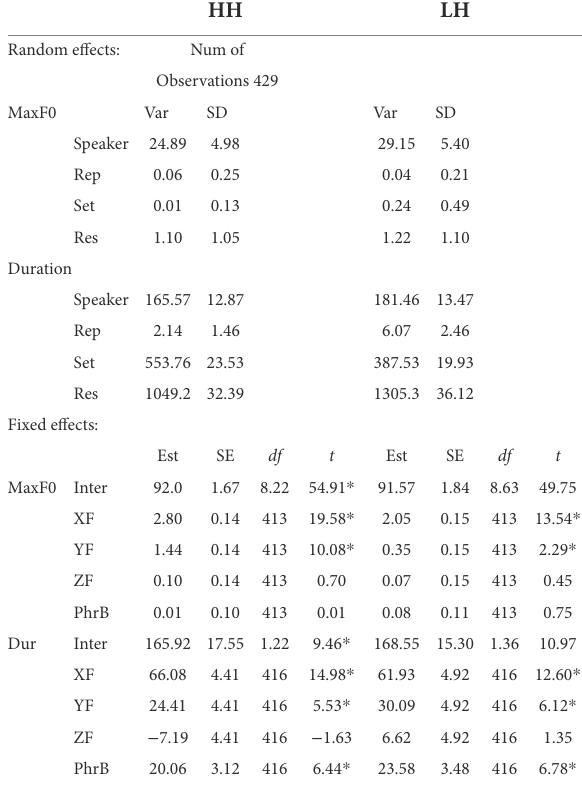
TABLE 1 LMM analysis on maximum F0 and duration in syllable X, with HH and LH sentences separately tested taking focus and boundary as non-interactive fixed factors, whereas speaker and set as random factors in the equation as lmer(dv ~